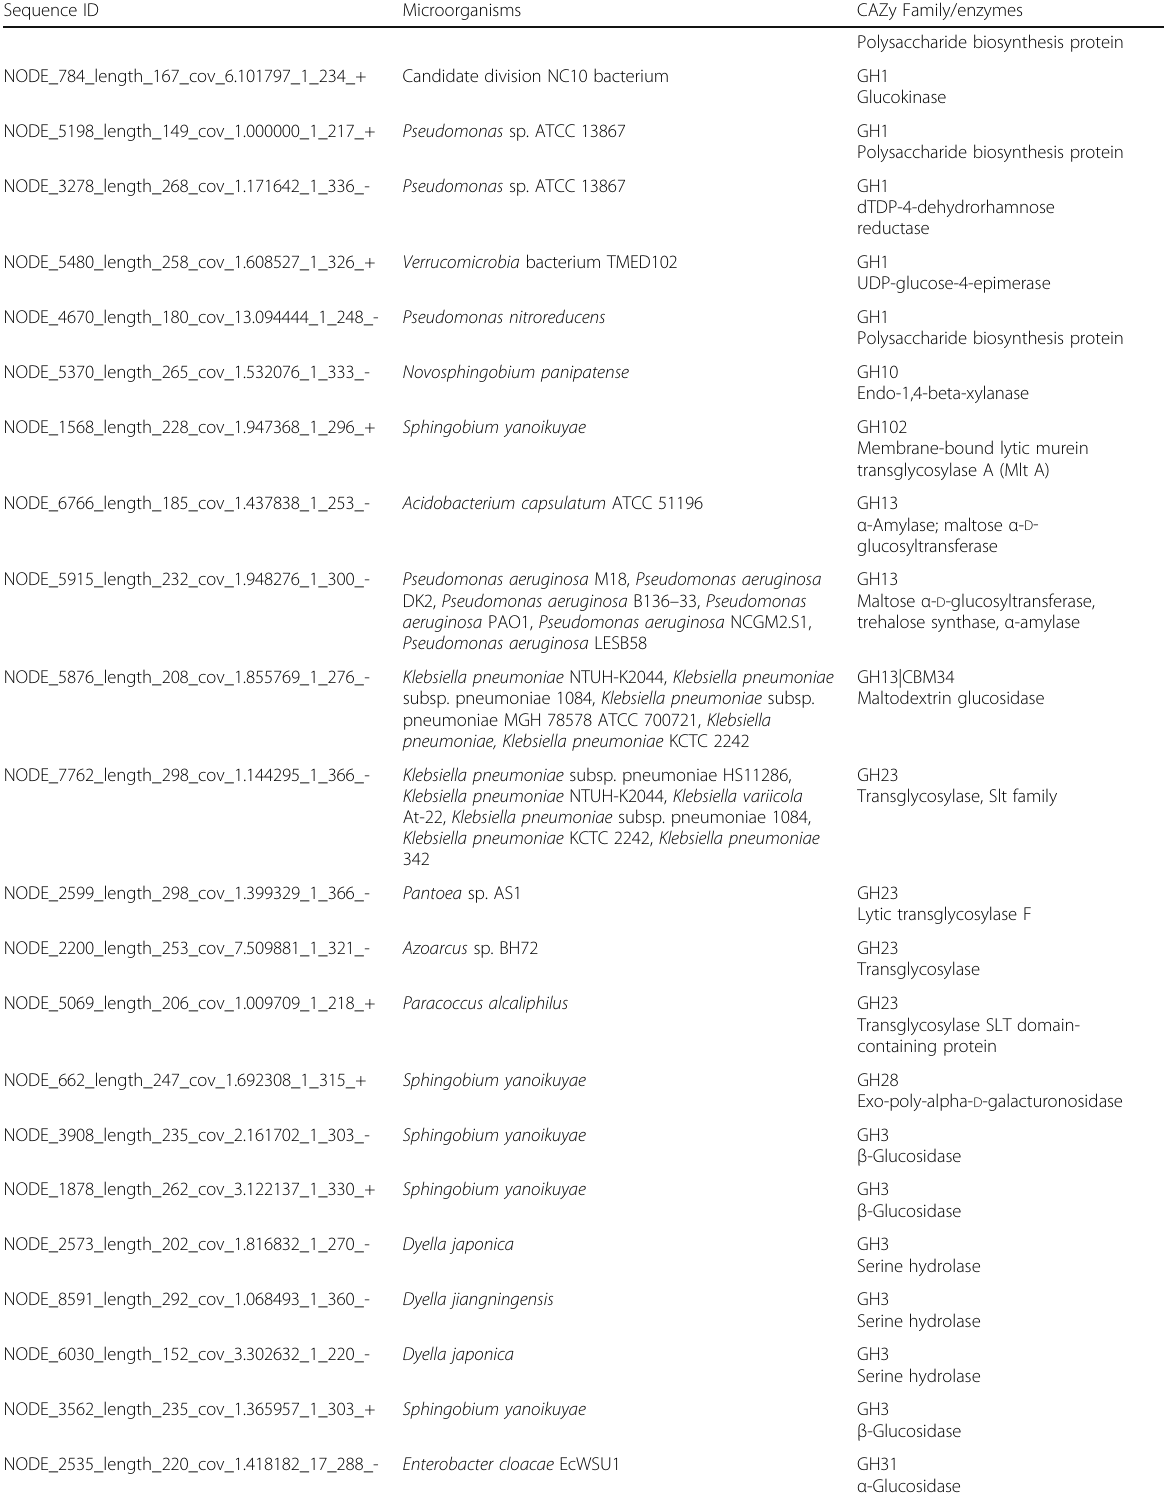
Table 2 List of AB1 microcosm sequences annotated for carbohydrate-active enzymes (CAZy) and their taxonomic affiliations